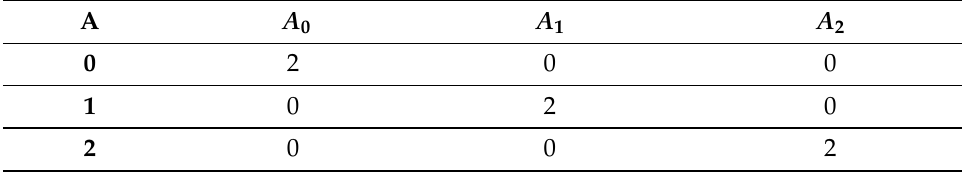
Table 4. Decoder truth